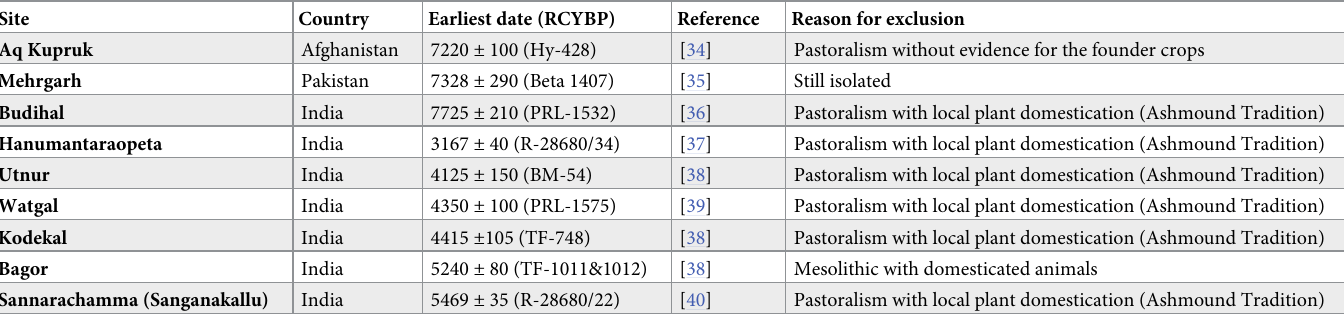
Table 1. Dates with a potential Neolithic association that have been excluded from the analysis.